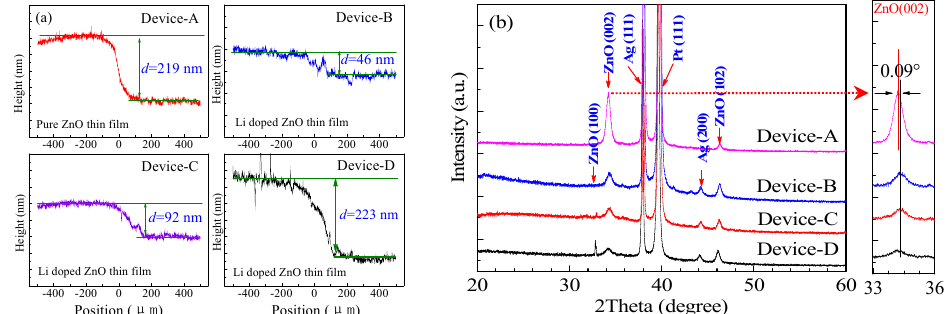
Figure 2. ( a ) The thicknesses of resistive switching layer; ( b ) XRD patterns of pure ZnO and Li-doped thin films, the inset shows magnified spectra near the ZnO (002) diffraction peak.